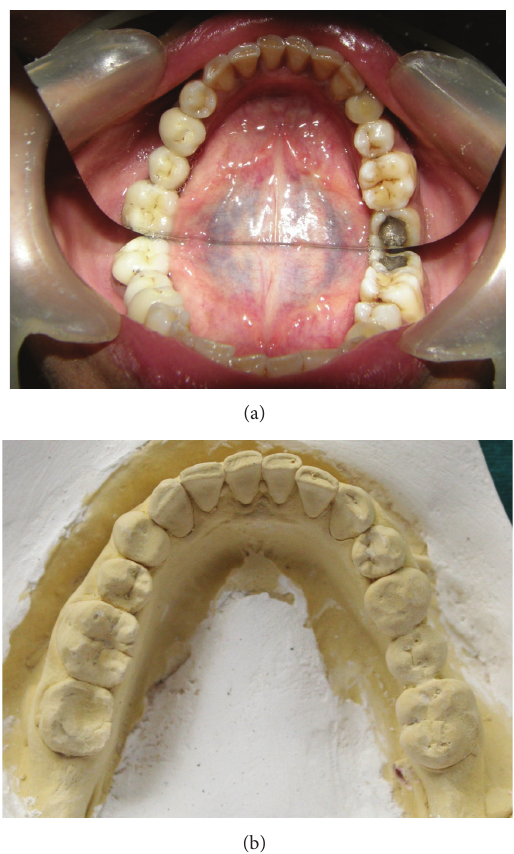
Figure 1: (a) Mirror image photograph showing 44 with mesi- olingual and distolingual cusp. (b) Photograph of mandibular cast showing 44 with typical “Y” shaped occlusal groove with 3 cusps resembling mandibular second